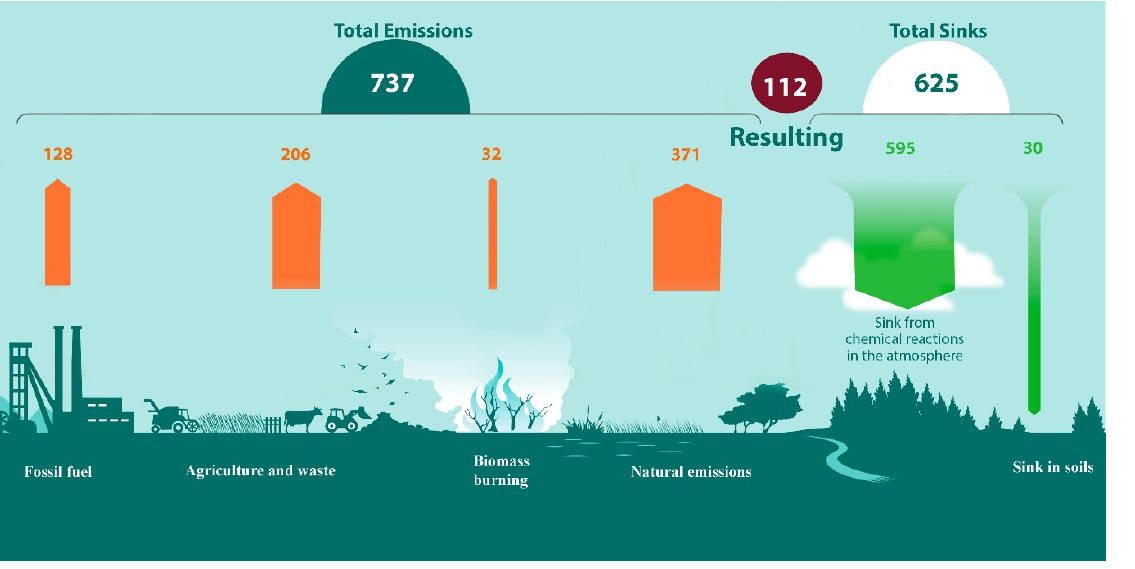
Figure 2. Global CH 4 budget modified from Saunois et al. [10].